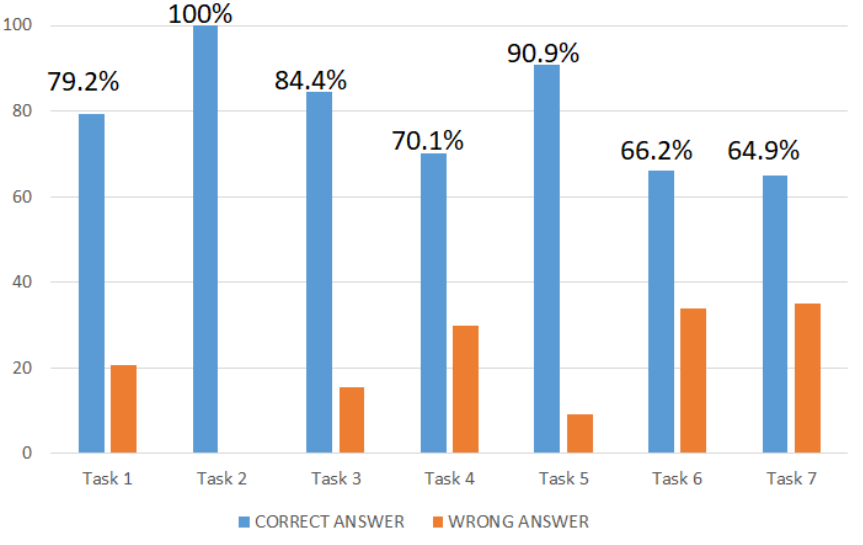
Figure 2. Scores (%) on seven subtasks.